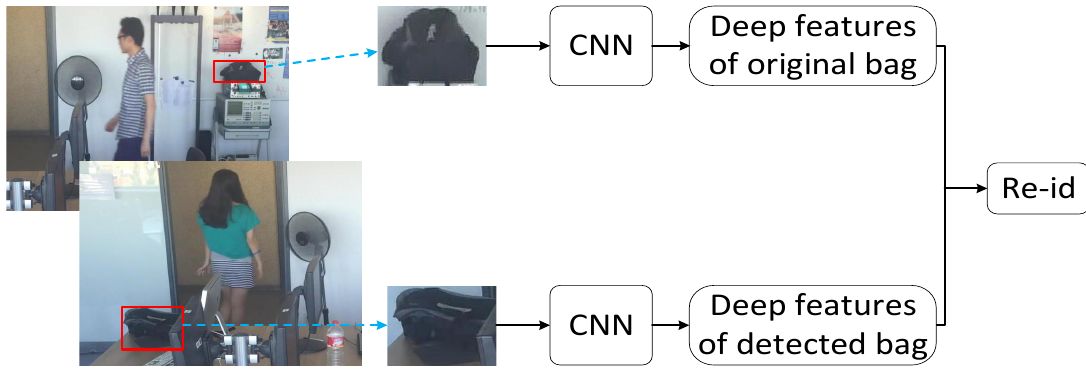
Figure 4: Flowchart for object verification. The process is very similar as person re-identification. But only one sample is extracted for each object when they are